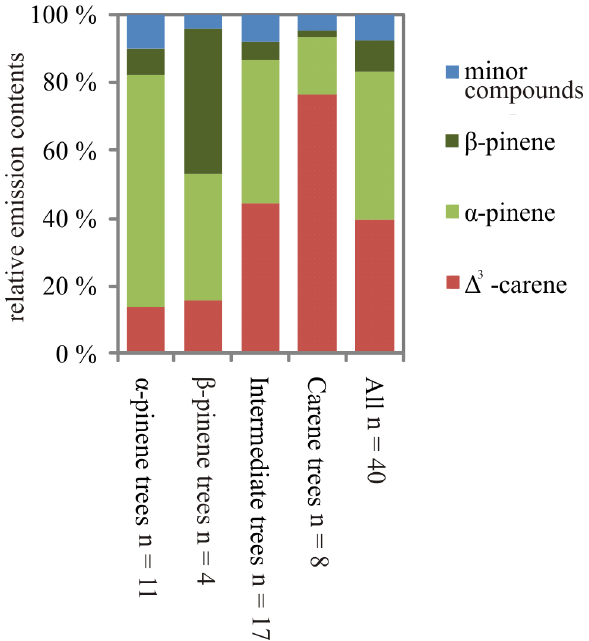
851 852 Fig. 6. Average relative emission contents of four clusters (type III clustering). Clusters are named as α -pinene trees, β -pinene